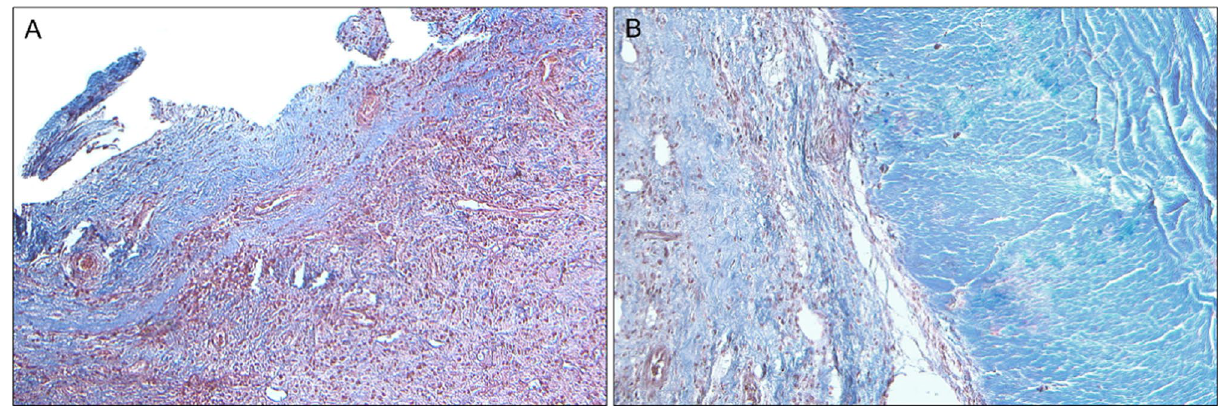
Figure 5. Light microscopy on paraffin sections of the inner membrane ( A ) and outer membrane ( B ) surrounding a CSDH. Collagen fibers are stained in blue, by Masson Trichrome with aniline blue histochemical staining (Bio-Optica); ( A ) 5 ×; ( B ) 10